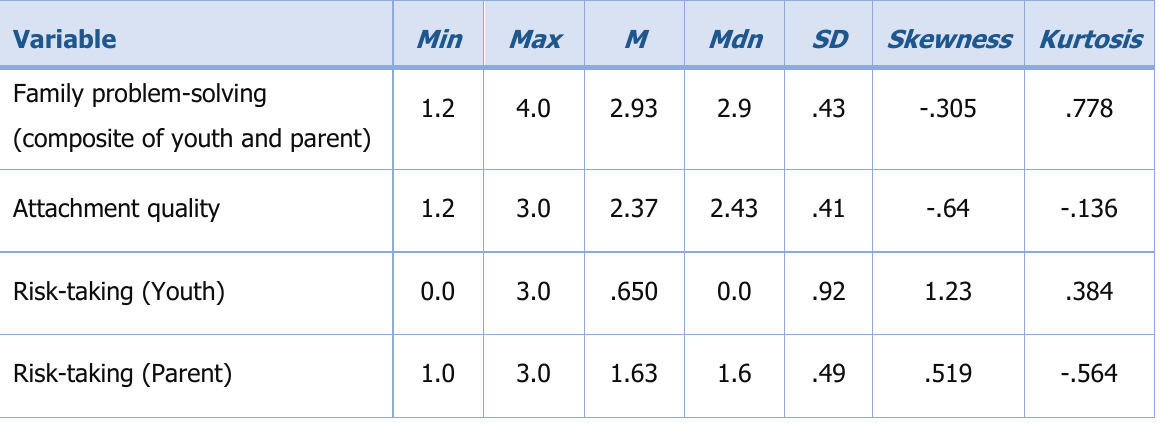
Table 1. Descriptive Statistics of Family Problem-Solving, Attachment Quality, and Risk-Taking